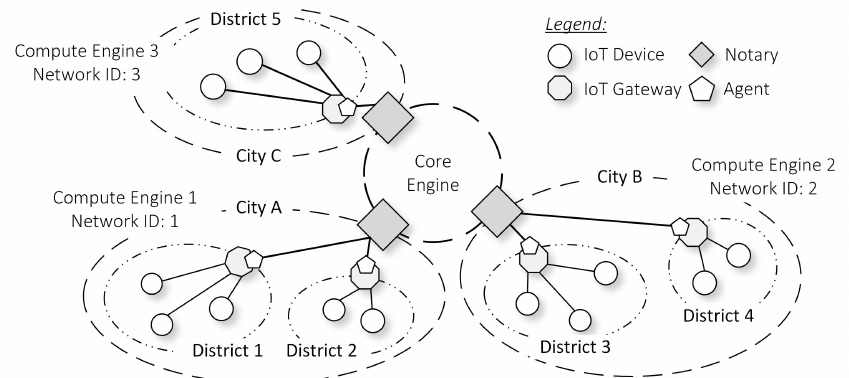
Figure 5. An illustration of Compute Engine parallelism scheme, clustered per city. IoT devices in each district connect to an IoT gateway that also acts as an Agent node for that particular Compute Engine. The gateway connects to any available Notary node in its city. Notary node and Agent nodes in a particular city manage their Compute Engines independently from other nodes in different